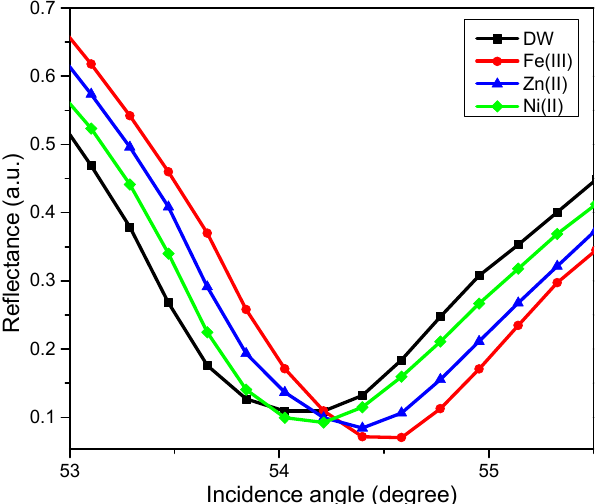
Figure 11. The SPR curves of CTAB / HGQDs thin film in contact with deionized water and 0.1 ppm of Zn 2+ , Ni 2+ , and Fe 3+ solutions.